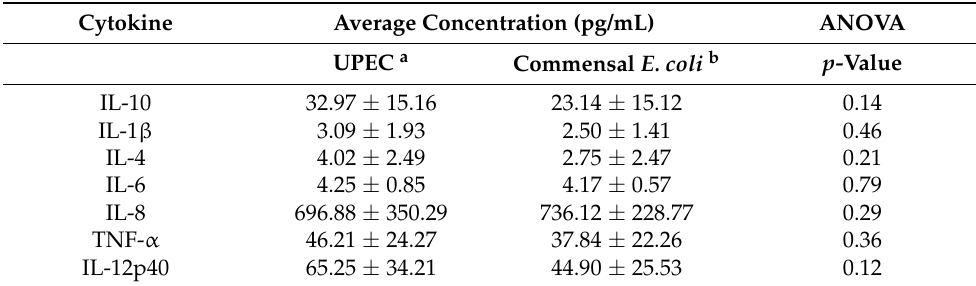
Table 2. Mean ± SD concentrations of cytokines produced by NPU cells, depending on the E. coli type (UPEC vs.